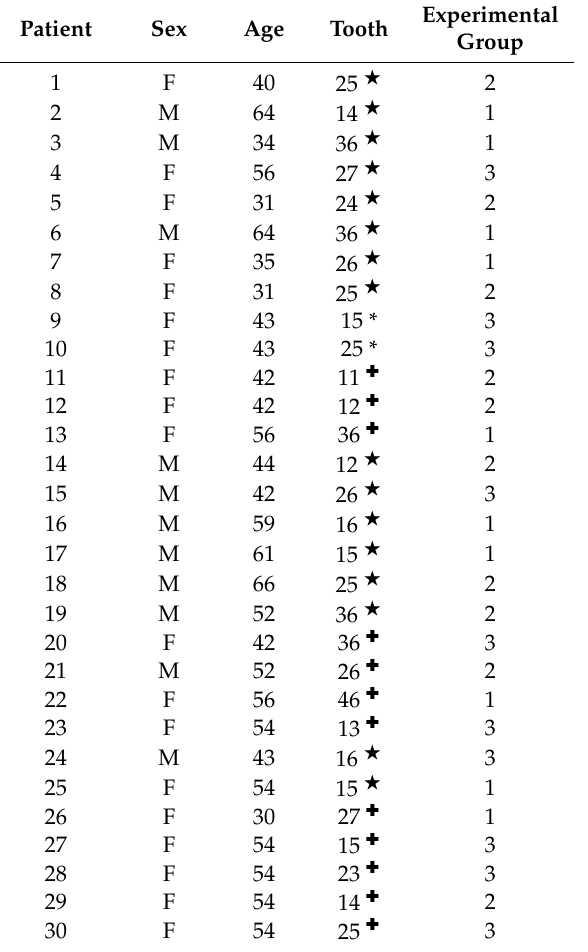
Table 2. List of research